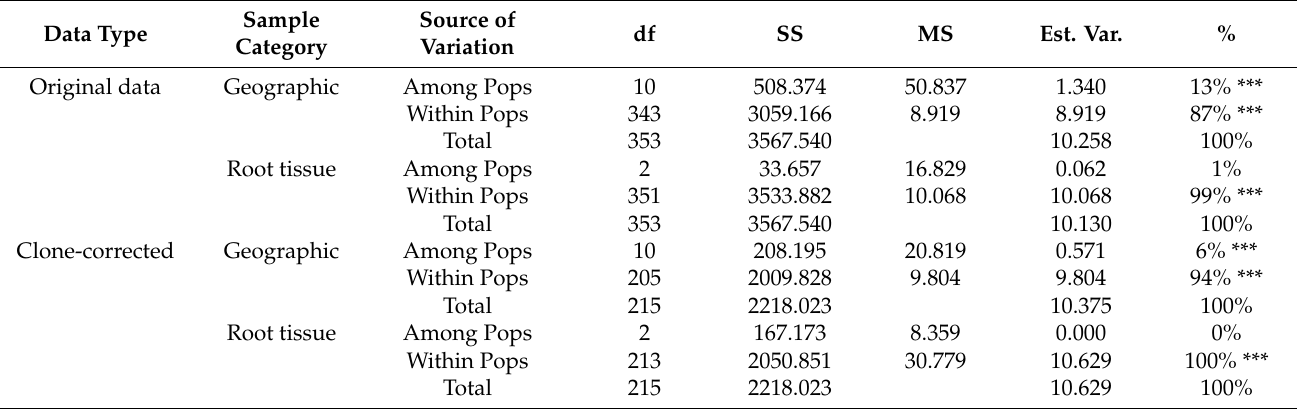
Table 5. AMOVA results for both the total sample and the clone-corrected samples. In the clone- corrected sample, only one strain of each genotype is included in each geographic population for analyses.